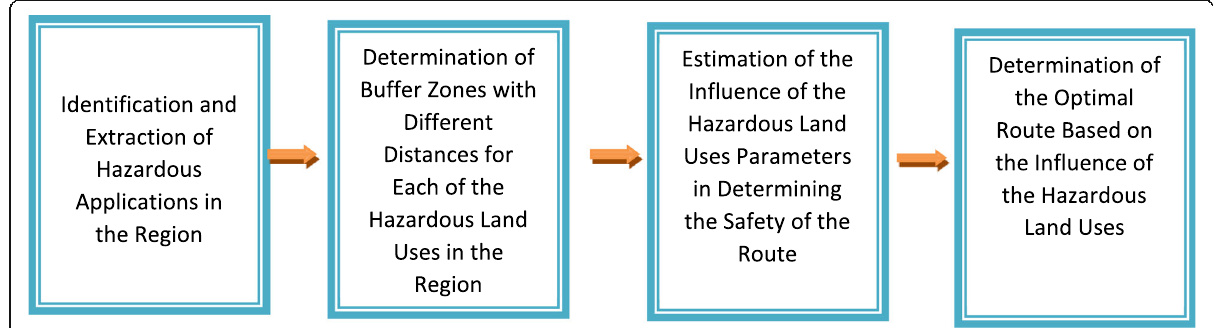
Fig. 5 Estimating hazardous land use index method and its optimal road determination